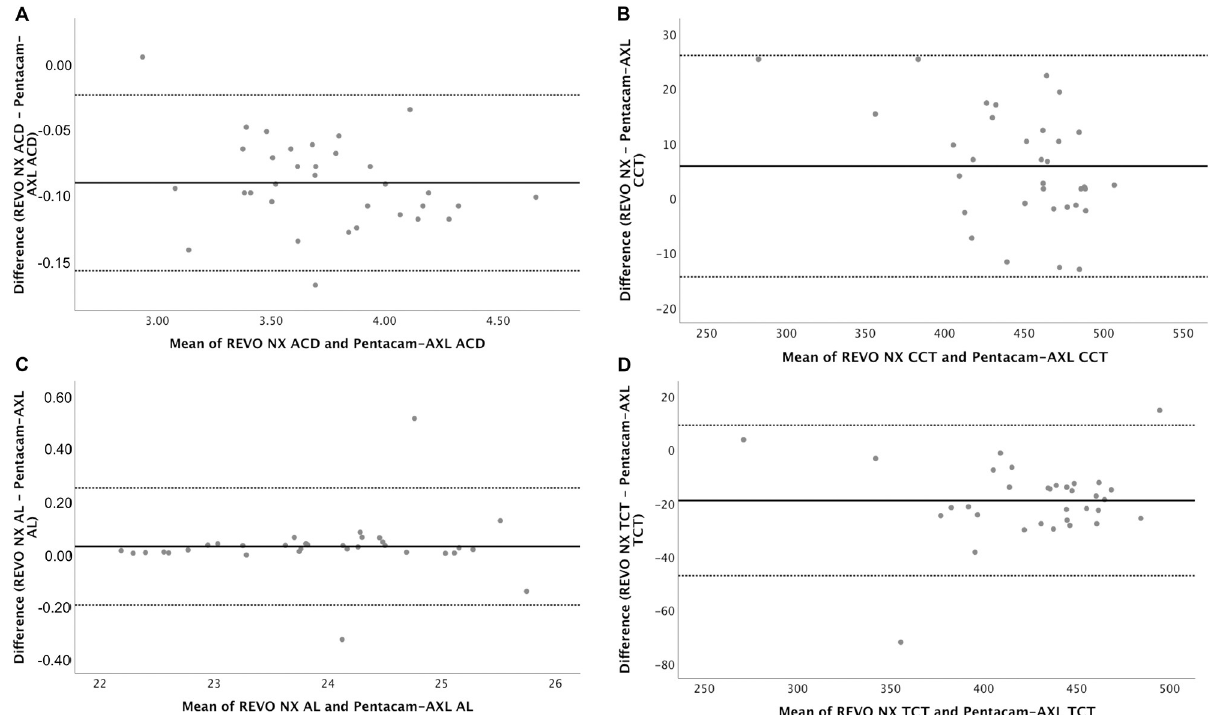
Fig 3. Bland-Altman plots for ACD (3A), CCT (3B), AL (3C), and TCT (3D) for REVO-NX and Pentacam-AXL in Group C eyes. ACD, anterior chamber depth; CCT, central corneal thickness; AL, axial length; TCT, thinnest corneal thickness.